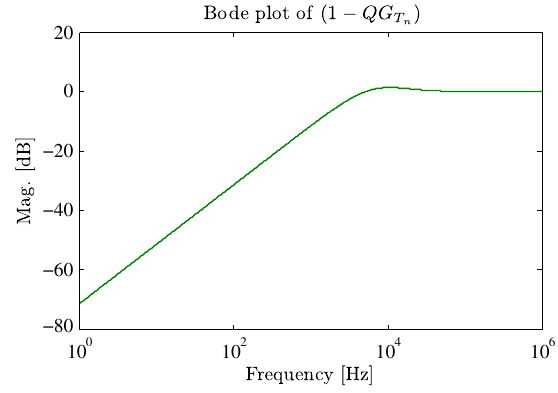
FIG. 8. Bode plots of the block, 1 − QG response indicated that the inequalities 1 − QG satisfied in the frequency range from DC to 5 kHz, as a result, the response from d to y in the PI þ DOB control will be improved in the corresponding frequency